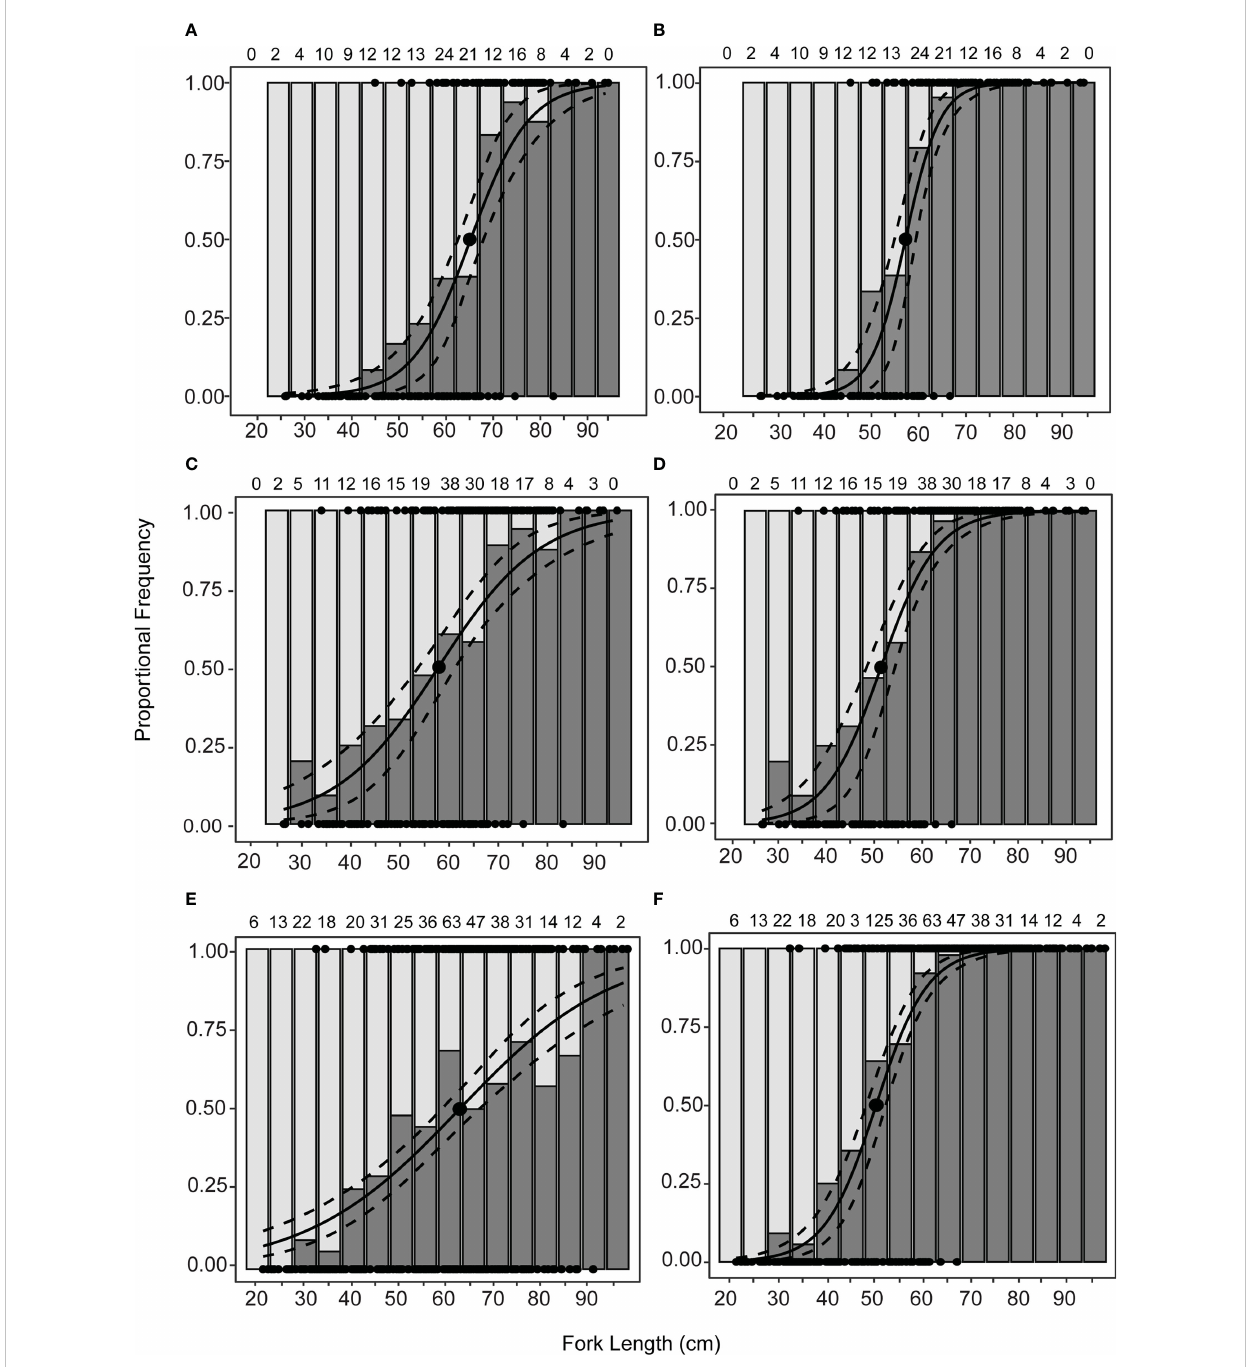
FIGURE 5 Fitted logistic regression for the proportion of mature female Etelis coruscans and proportional frequency of immature (light grey) and mature (dark grey) by 5-cm length bins. Dashed lines indicate ± 95% con fi dence intervals. Dark circles indicate L 50 . Sample size for each length bin is indicated on top of each graph. Maturity classi fi cation is based on the histological criteria, functional vs. physiological maturity determination, and inclusion or exclusion of the September – December spawning period. Hybrid estimates include fi sh in the regenerating reproductive phase. The McFadden ’ s R 2 values indicate the proportion of variation explained by the model. (A) Functional maturity during spawning period; L 50F = 65.8 cm FL, R 2 = 0.40. (B) Physiological maturity during spawning period; L 50P = 57.2 cm FL, R 2 = 0.62. (C) Functional hybrid during spawning period; L 50FH = 58.0 cm FL, R 2 = 0.21. (D) Physiological hybrid during spawning period; L 50PH = 51.6 cm FL, R 2 = 0.44. (E) Functional maturity during all months; L 50FY = 62.1 cm FL, R 2 = 0.14. (F) Physiological maturity during all months; L 50PY = 50.0 cm FL, R 2 =